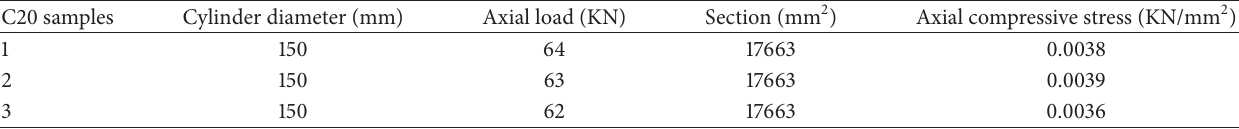
Table 2: Detailed results of the sample concrete cylinders.